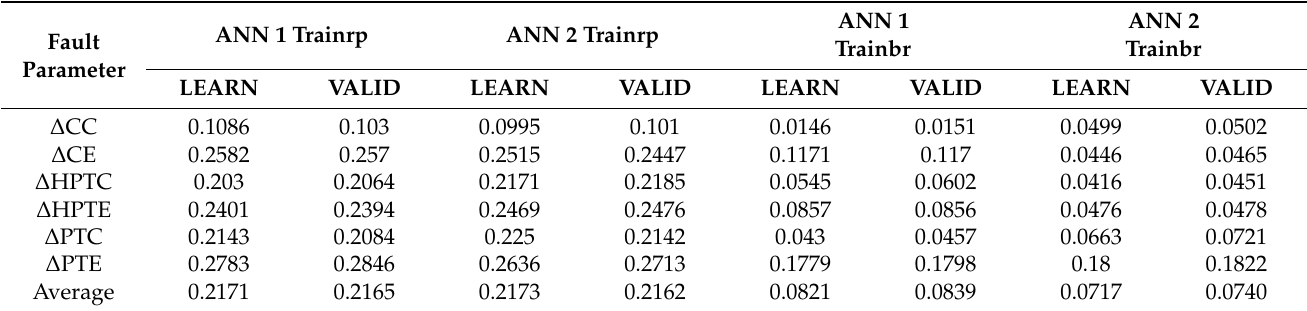
Table 5. RMSE for best MLP configurations of extended diagnostic model.